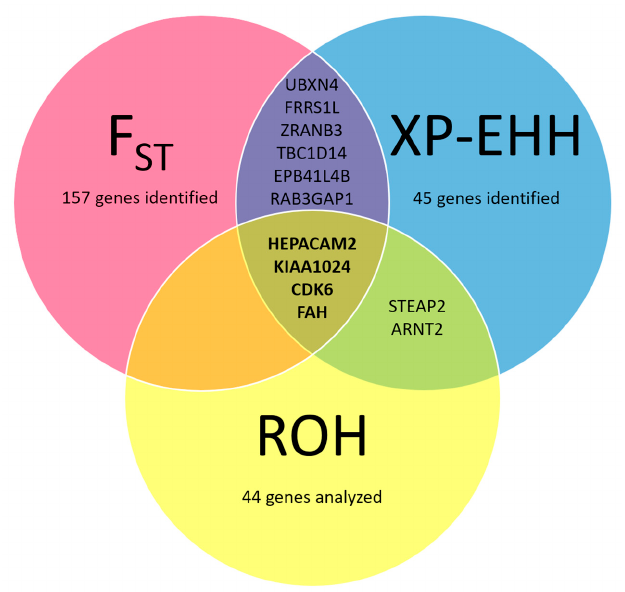
Figure 2. Manhattan plots of the cross-population extended haplotype homozygosity (XP-EHH) analysis comparing cases vs. controls. Manhattan plot of log 10 XP-EHH values. Each SNP is represented by a dot. Each chromosome is represented by a different color. The dotted red line represents the cutoff value of the top 1%, equal to 2.73. The genomic regions in which SNPs were mapped over the dotted red line were considered as significantly different between the two compared groups.